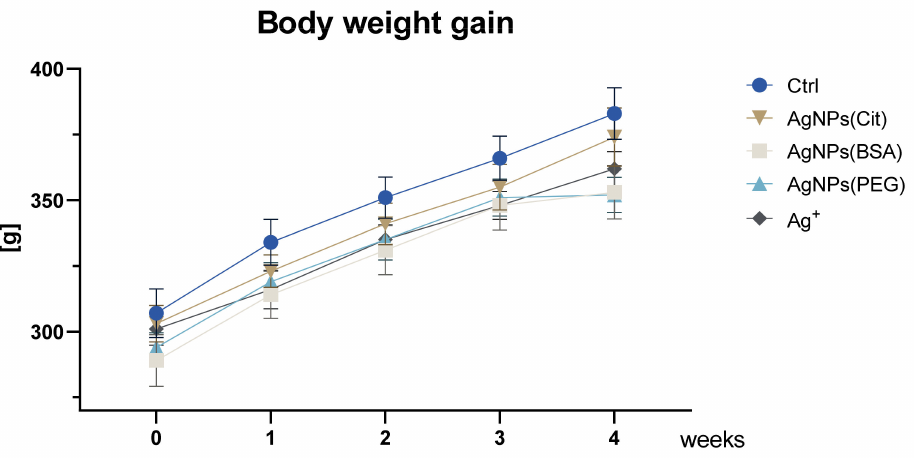
Figure 1. Body weight gain of rats during the experiment (mean ± SEM). (two-way repeated measures ANOVA: effect of group, F 4,33 = 1.56, NS; effect of day, F 4,132 = 446.05, p = 0.000; effect of group-by-day interaction, F 4,132 = 2.11, p =